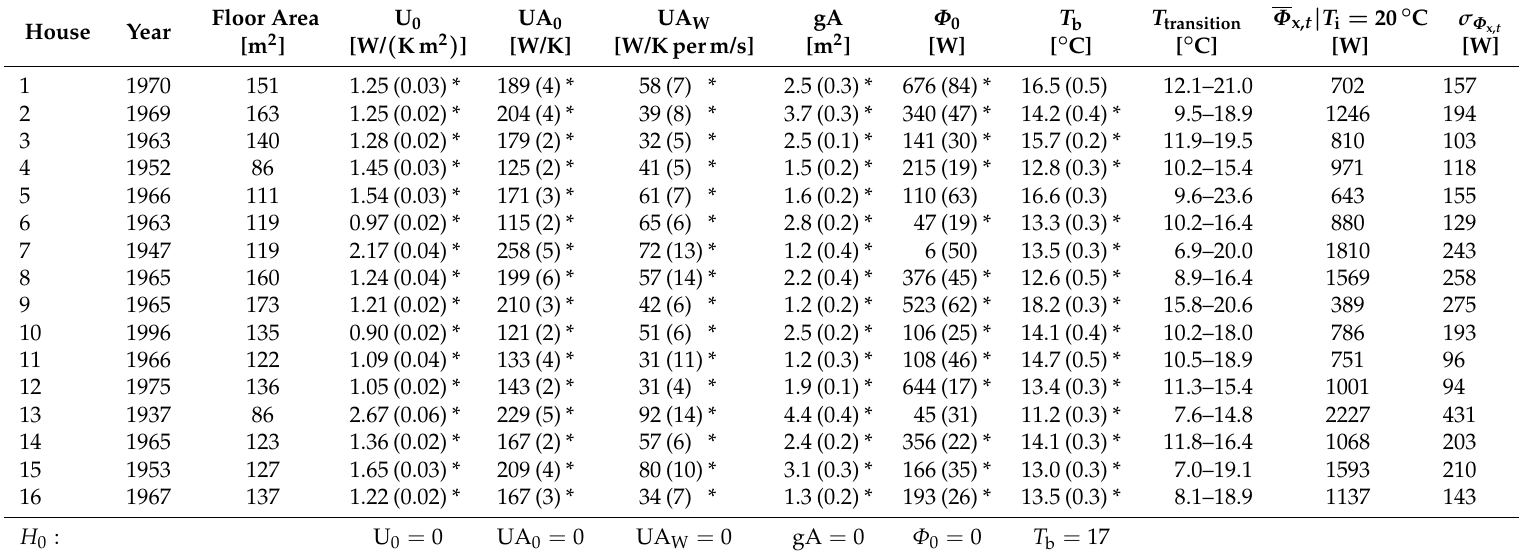
Table 2. Estimated performance parameters for 16 houses in Denmark. The number in parentheses states the standard error of the parameters. U 0 and UA 0 are the heat loss coefficients under wind-free conditions, and UA W is the wind-dependent increment in the UA value. T transition states the range of outdoor temperatures at which the building is in transition from heating to non-heating period, given no wind and solar irradiation. Finally, Φ x, t | T i = 20 ◦ C and σ Φ standard deviation, respectively, of the estimated time-varying heat balance contribution required to obtain thermal balance with an indoor temperature of 20 ◦